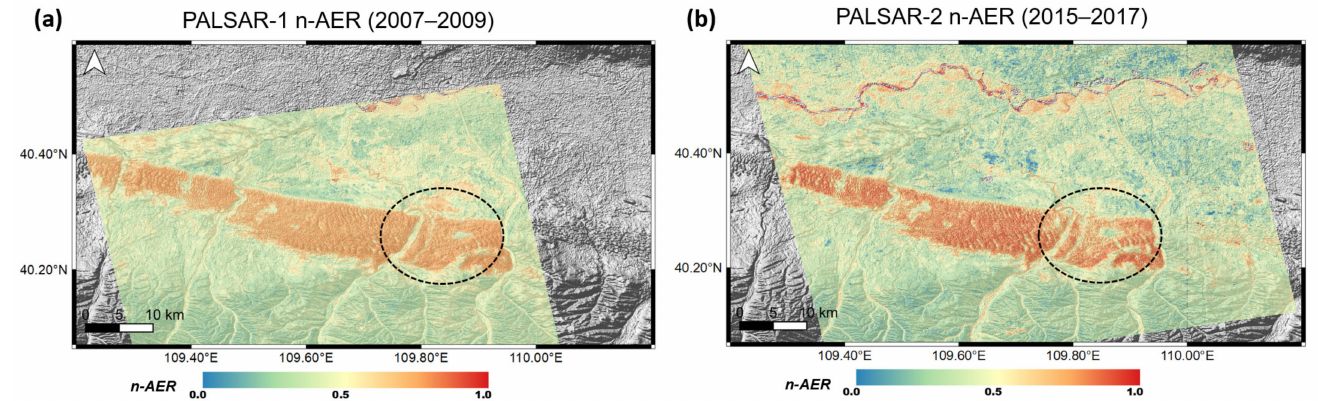
Figure 11. Normalized aeolian erosion (n-AER) maps using ALOS PALSAR-2 pairs of 2007–2009 ( a ) and 2015–2017 ( b ). Two n-AER maps now can be assessed against each other as the data ranges of the two maps used the process of employing control points (see Figure 8a). The effects of activities to combat desertification are evident as presented in circled